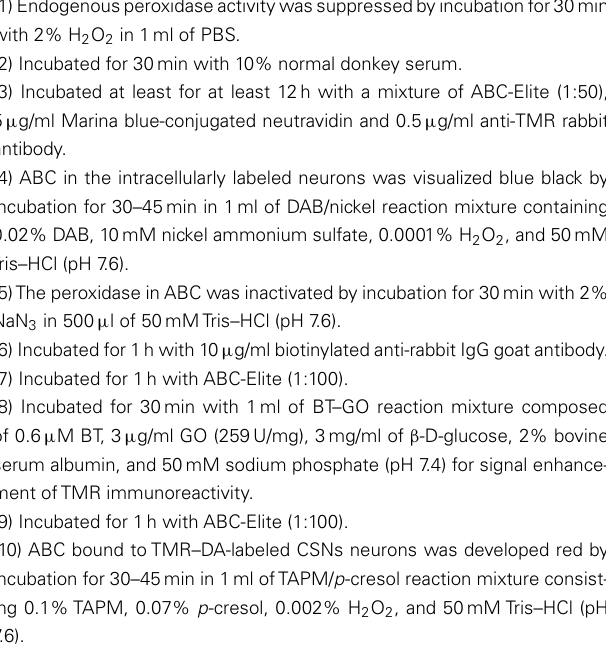
FIGURE 1 | Chemical and electrical properties of L5 GABAergic interneurons in the motor areas. (A–B (cid:2)(cid:2) ) Almost all PV- and SOM immunopositive L5 neurons expressedVenus in the motor areas of VGAT-Venus transgenic rats. (C,C (cid:2) ) AVenus-expressing cell was attached and recorded with a patch electrode (arrowhead). (D–F) Left traces show the responses of L5 FS neurons, SOM neurons, and non-FS/non-SOM neurons, respectively, to 500-ms-long depolarizing current pulse injection. Right traces display the shape of action potential, where a passive component was subtracted from the raw trace (Kaneko et al., 1995). (G–H (cid:2) ) Arrowheads indicate biocytin-labeled GABAergic interneurons (G,H) that were immunoreactive for PV (G (cid:2) ) or SOM (H (cid:2) ) . DIC, differential interference contrast microscopy. Scale bar in (B (cid:2)(cid:2) ) applies to (A–B (cid:2)(cid:2) ) , that in (C (cid:2) )